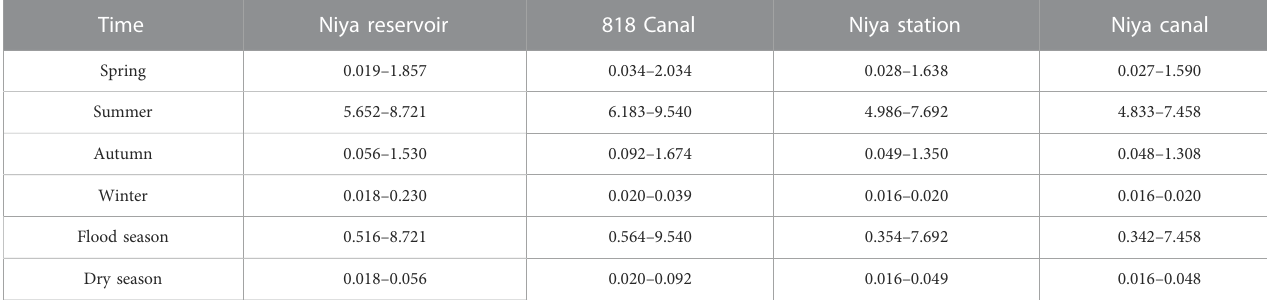
TABLE 3 Ecological base fl ow guarantee objectives of 4 sections. Unit: m 3 · s − 1